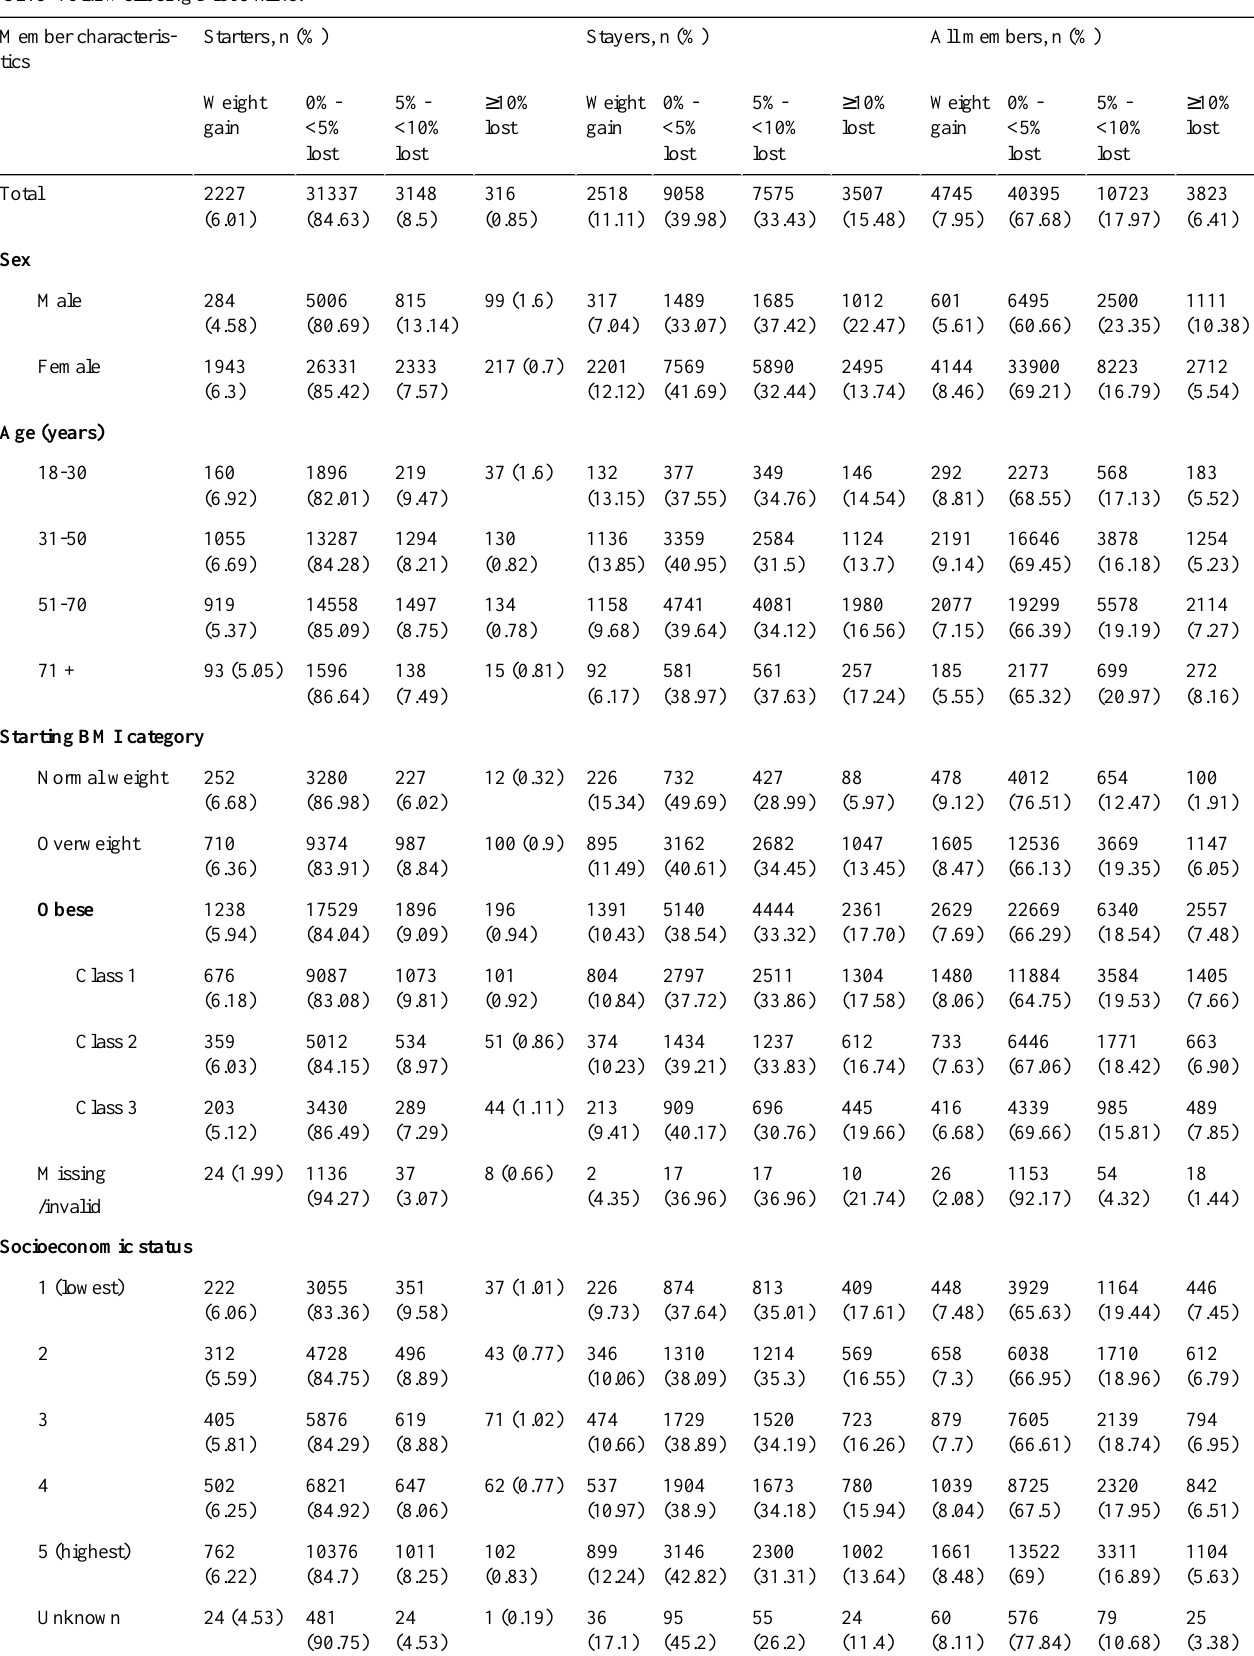
Table 3. Percentage of the sample within weight loss categoriesa,b for starters (n=37,028), stayers (n=22,658), and all members (N=59,686) on the CSIRO Total Wellbeing Diet Online.